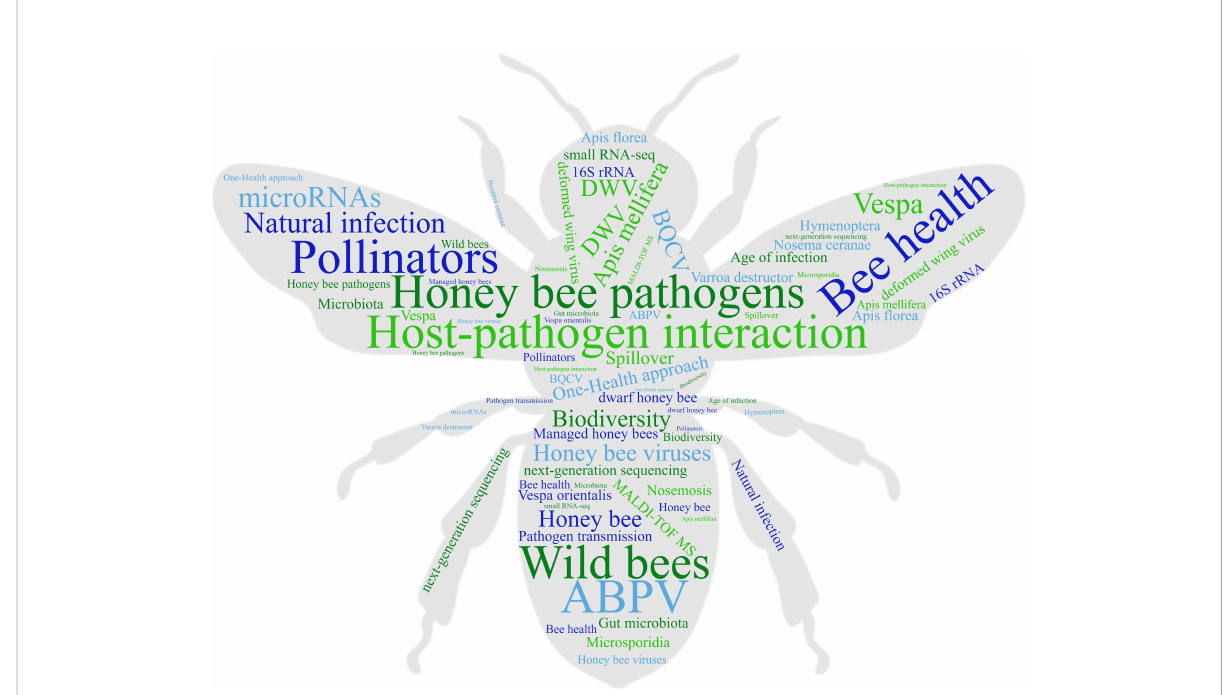
FIGURE 1 A word cloud created from the titles and keywords of every article published on the Research